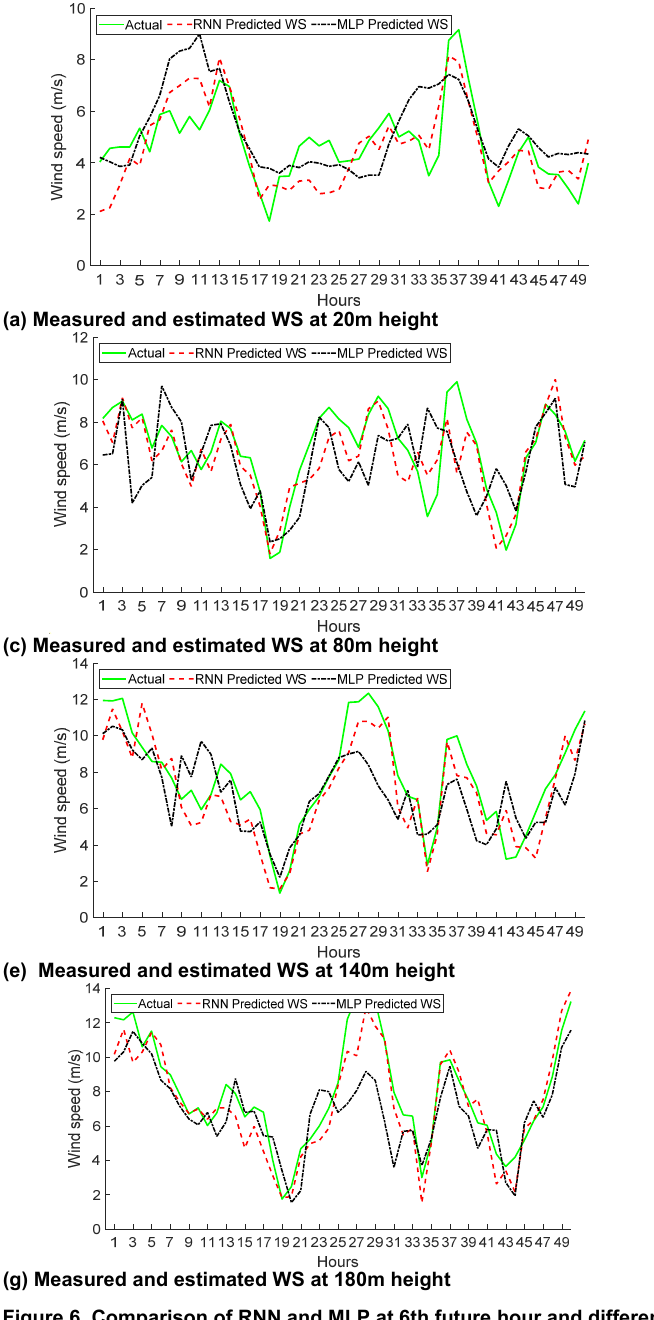
Figure 6. Comparison of RNN and MLP at 6th future hour and different